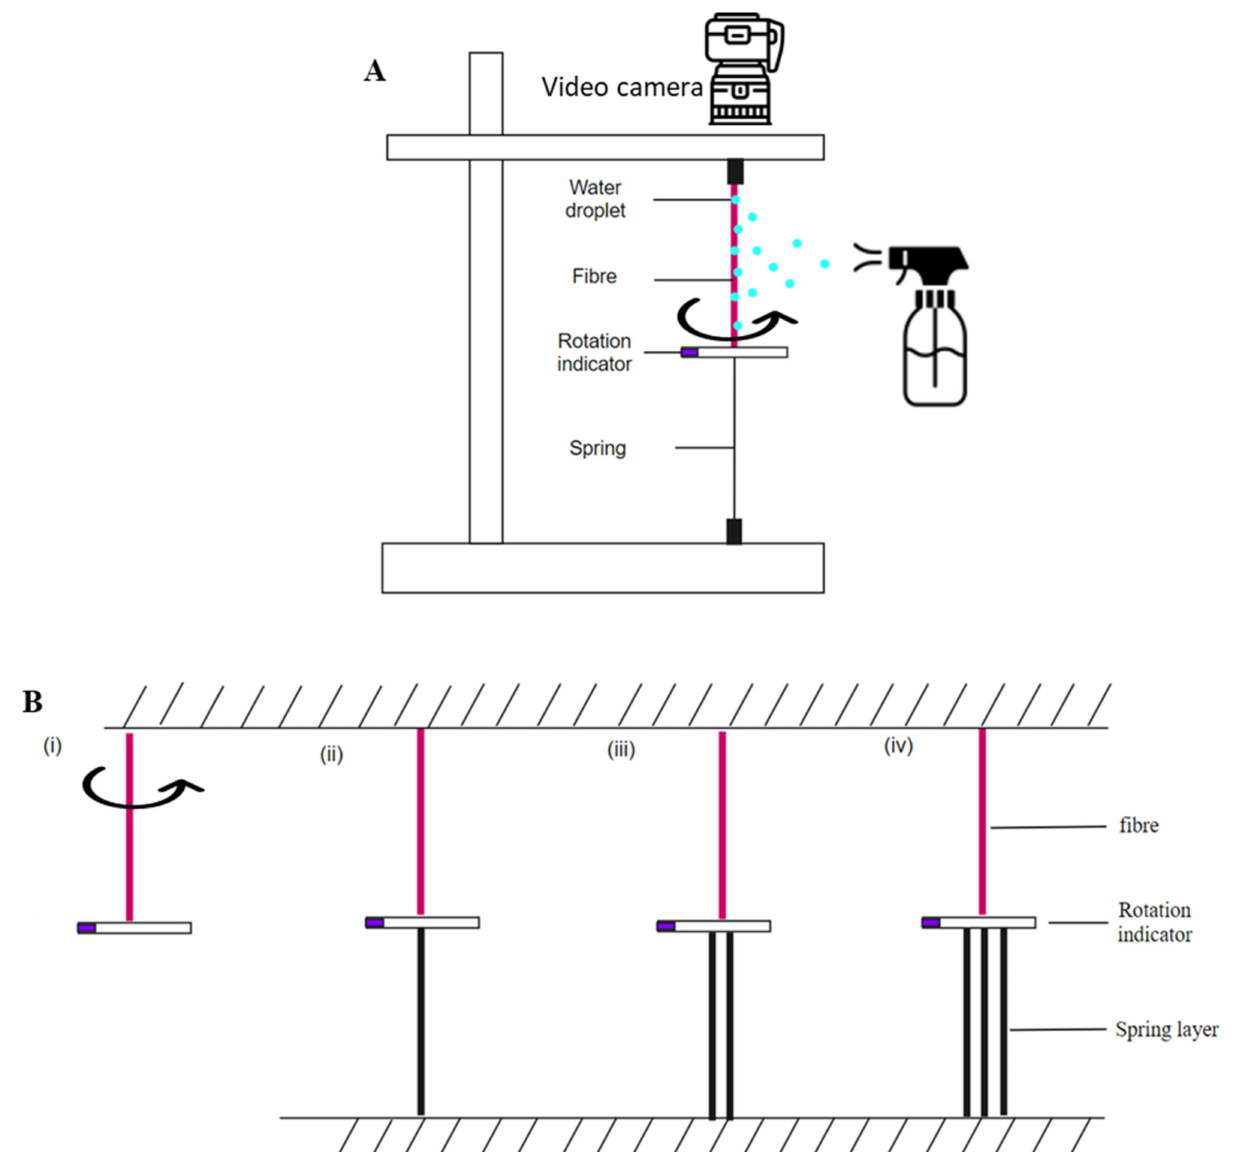
Figure 2. Schematic illustration of the actuation test method: ( A ) A complete test set up; ( B ) comparative test methods considering free rotation and rotation against return